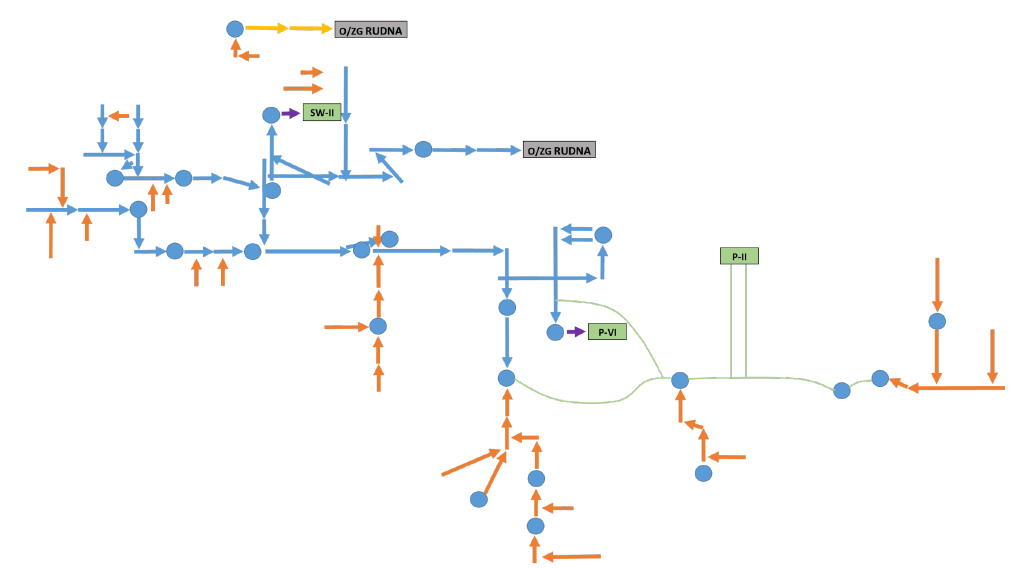
Figure 2. The conveyor system in KGHM OZG Polkowice-Sieroszowice mine. Each elementary segment is a separate conveyor, scale of the system makes frequent inspection difficult. Each arrow means conveyor, each circle bunker for ore